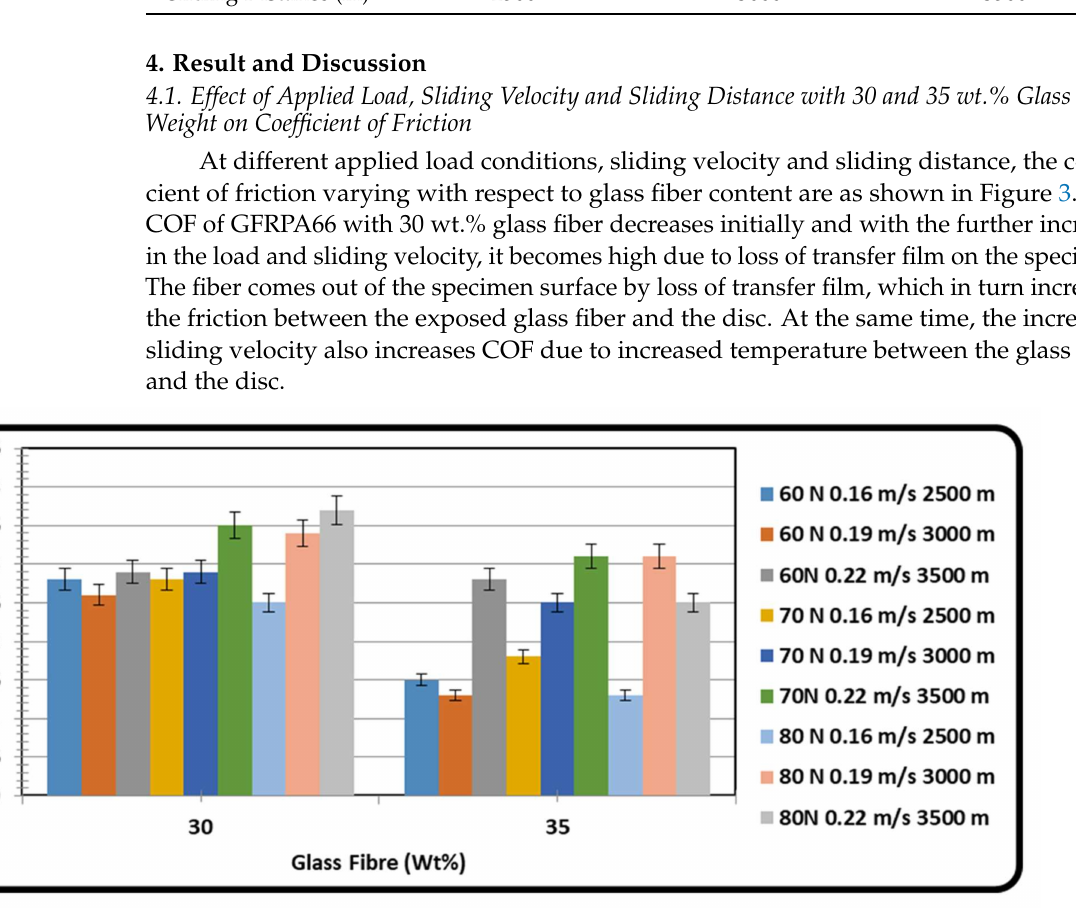
Figure 3. Effect of glass fiber content on COF at varying loads, sliding velocities, and sliding